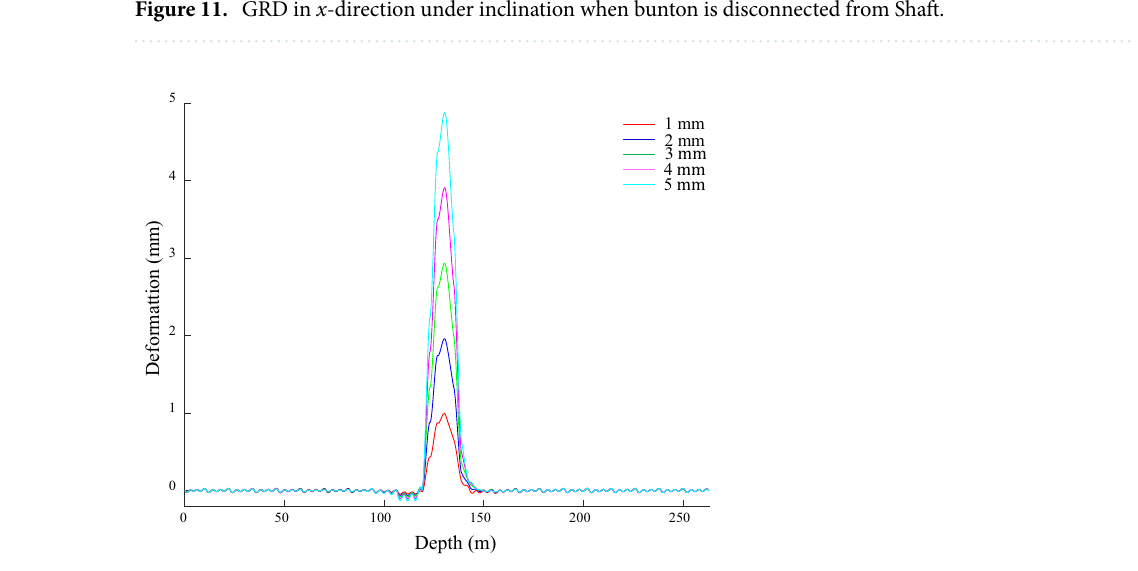
Figure 11. GRD in x -direction under inclination when bunton is disconnected from Shaft.